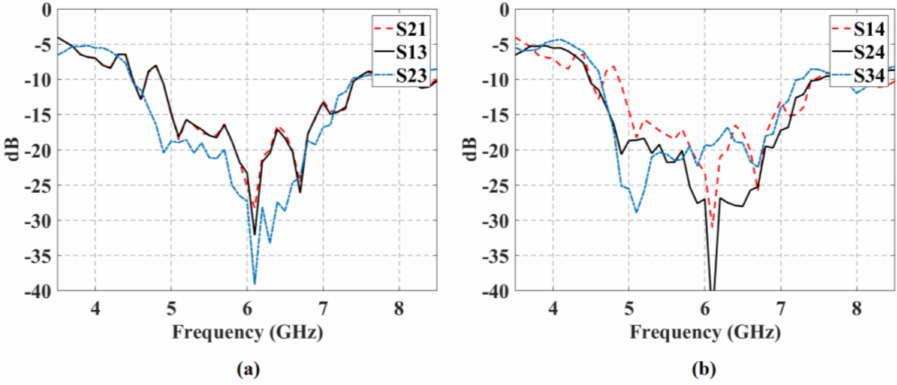
Figure 8. Isolation values versus frequency for the block of 4 × 7 CORPS.